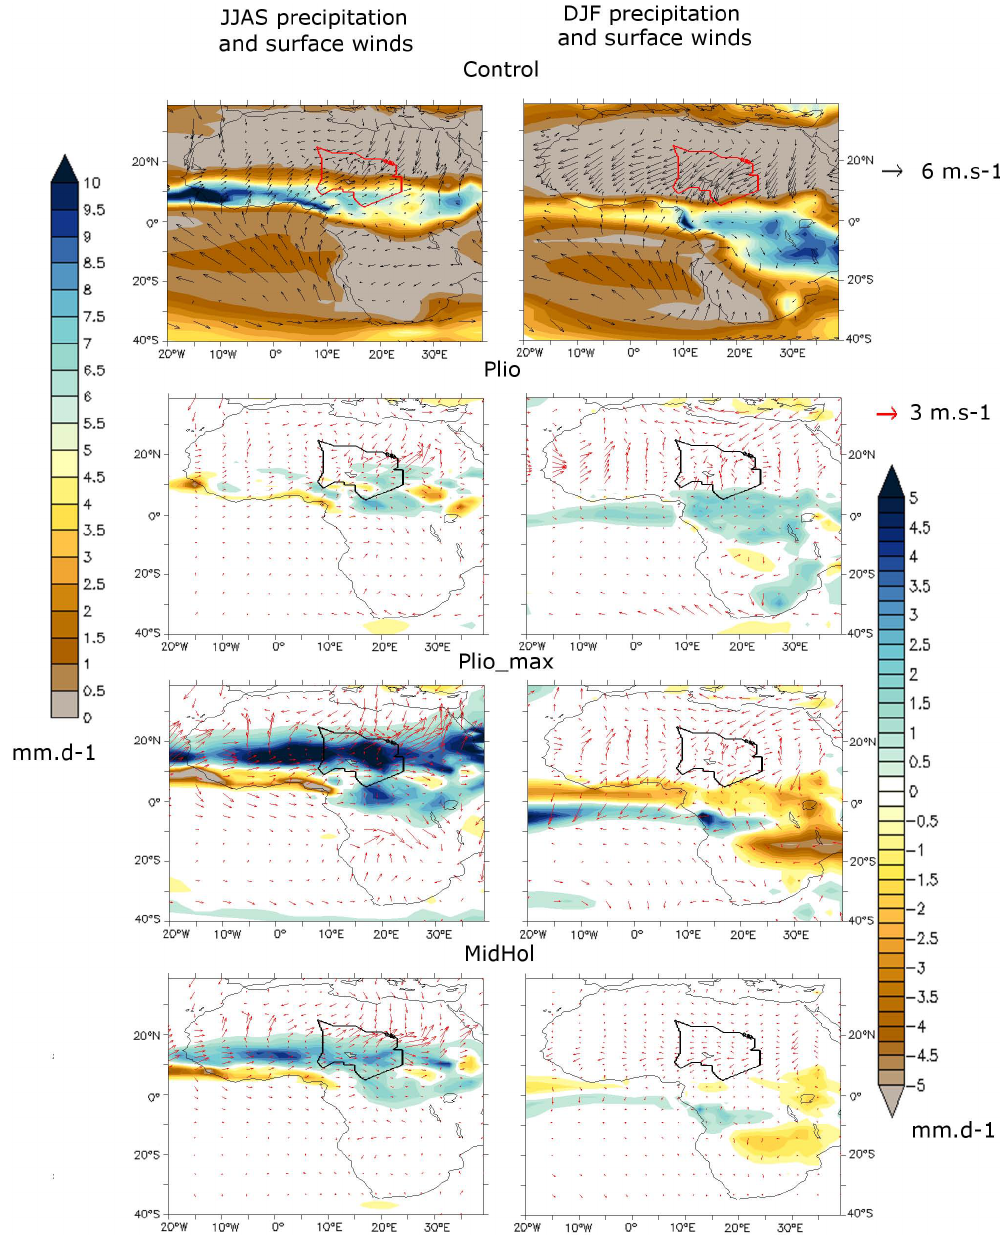
Fig. 5. Left: JJAS precipitation and mean low-level winds, anomalies to the control run. Right: the same for